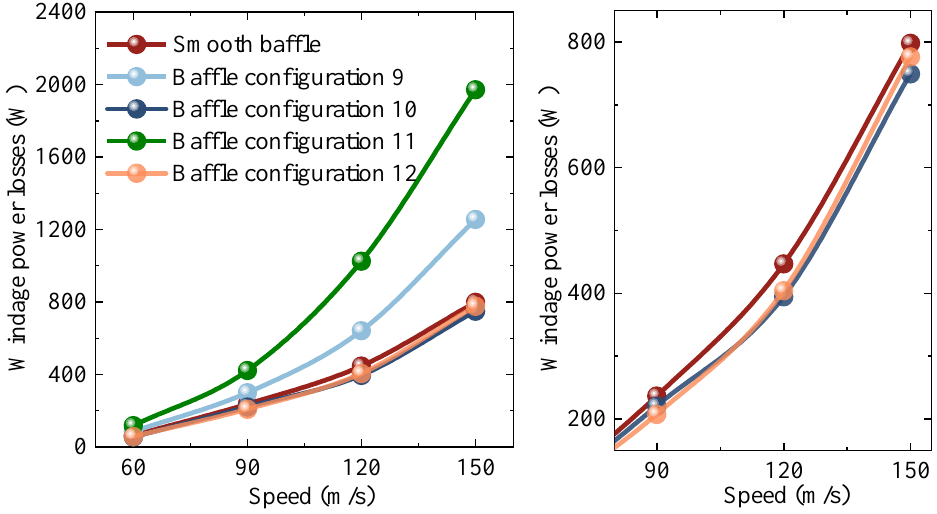
Figure 15. WPL of different grooved baffle configurations.